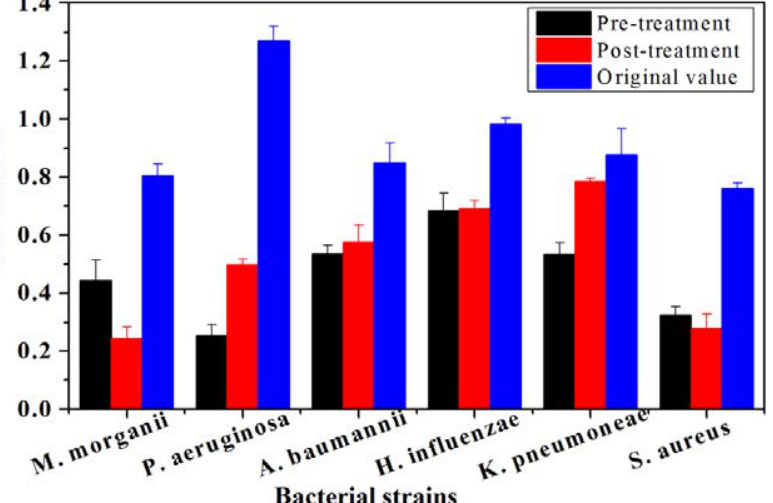
Fig. 3. Comparative analysis of biofilm growth of six bacterial strains on a microtiter plate before and after pre and post treatment by Acacia modesta stem. Bars represent means ± standard errors for three